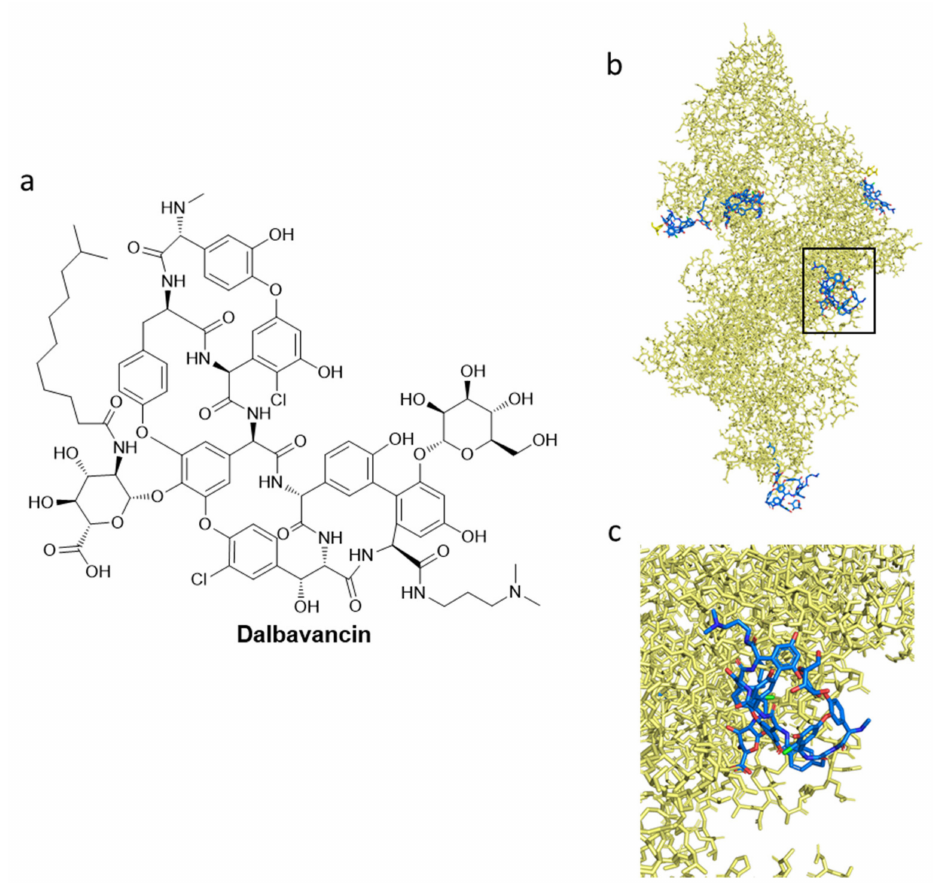
Figure 11. ( a ) Chemical structure of dalbavancin; ( b , c ) crystal structure (entire structure and close-up, respectively) of dalbavancin (blue) in complex with human serum albumin (HAS, yellow), PDB ID: 6M5E [198]. Figure made by ChemDraw and